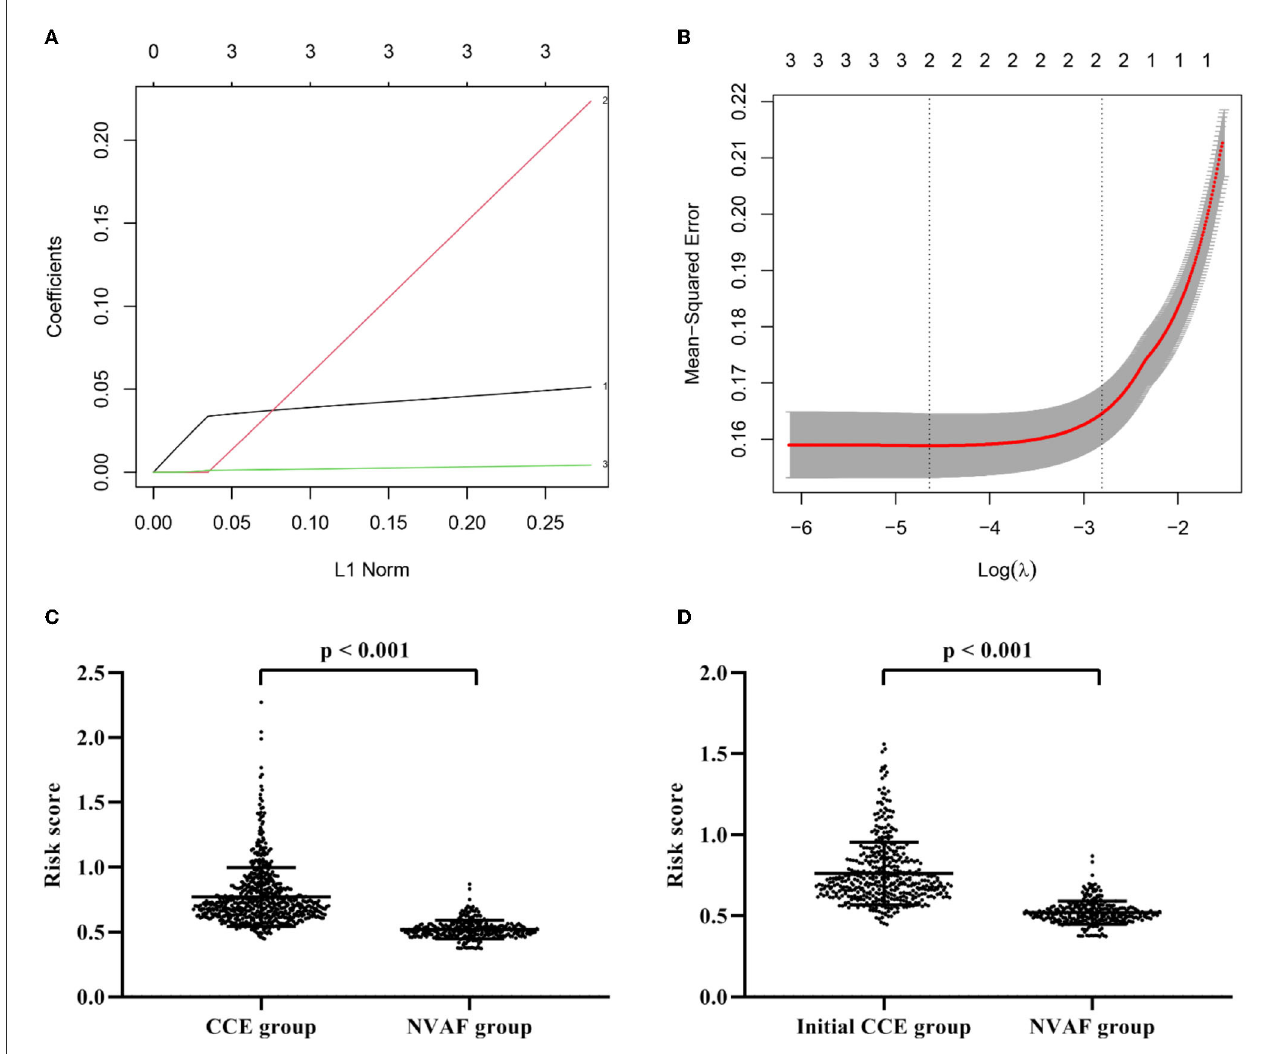
FIGURE2 Construction of a composite indicator using least absolute shrinkage and selection operator model. (A) The coefficients of each variate in the model (1: D-dimer; 2: PLR; 3: NLR). (B) The mean-squared error of model. (C) The significant difference in the risk score between CCE patients and single NVAF patients. (D) The significant difference in the risk score between initial CCE patients and single NVAF patients. CCE, cardiogenic cerebral embolism; NVAF, non-valvular atrial fibrillation; PLR, platelet-to-lymphocyte ratio; NLR, neutrophil-to-lymphocyte